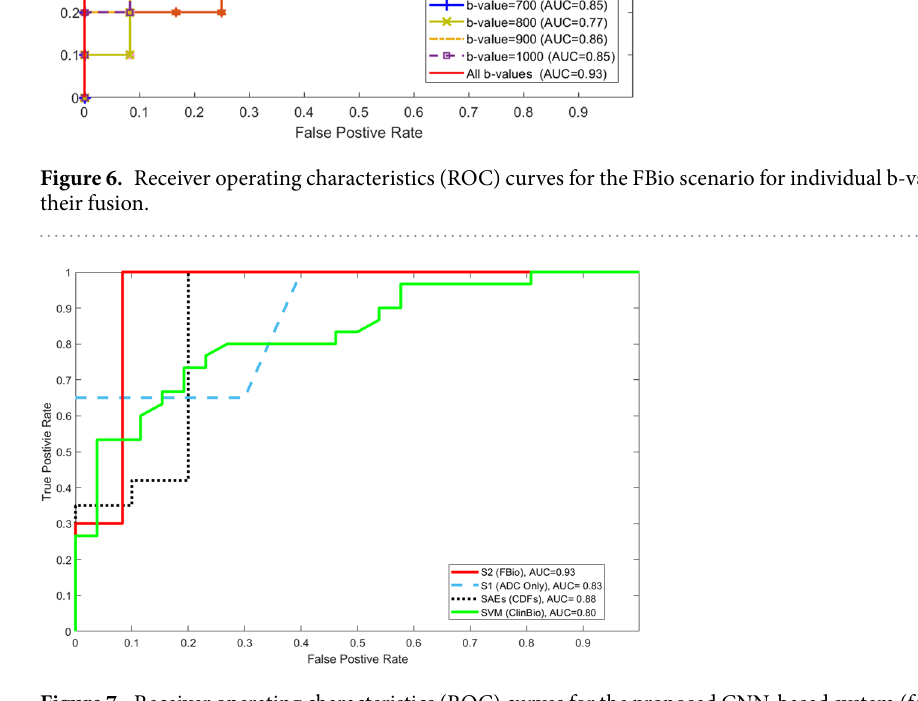
Figure 7. Receiver operating characteristics (ROC) curves for the proposed CNN-based system (for both scenarios S 1 and S 2 ), the clinical biomarkers (ClinBio) based upon using a support vector machine (SVM) classifier, and the auto-encoding system 42